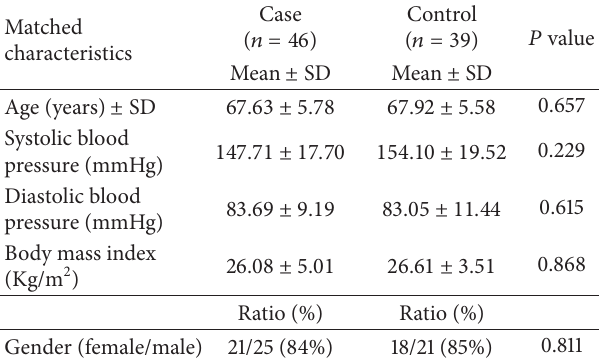
Table 1: Comparison of characteristics of stroke cases and matched controls.